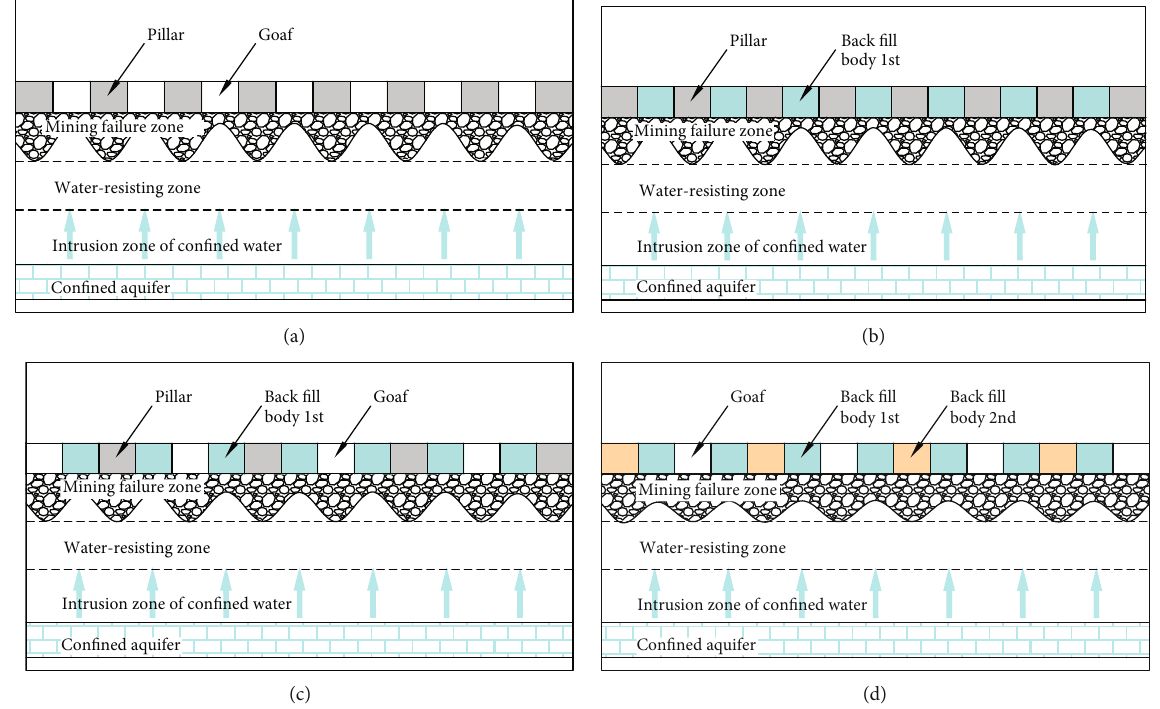
Figure 3: Schematic diagram of the back fi ll replacement mining above a con fi ned aquifer: (a) strip mining, (b) goaf fi lling, (c) the fi rst back fi ll replacement mining, and (d) the second back fi ll replacement mining.